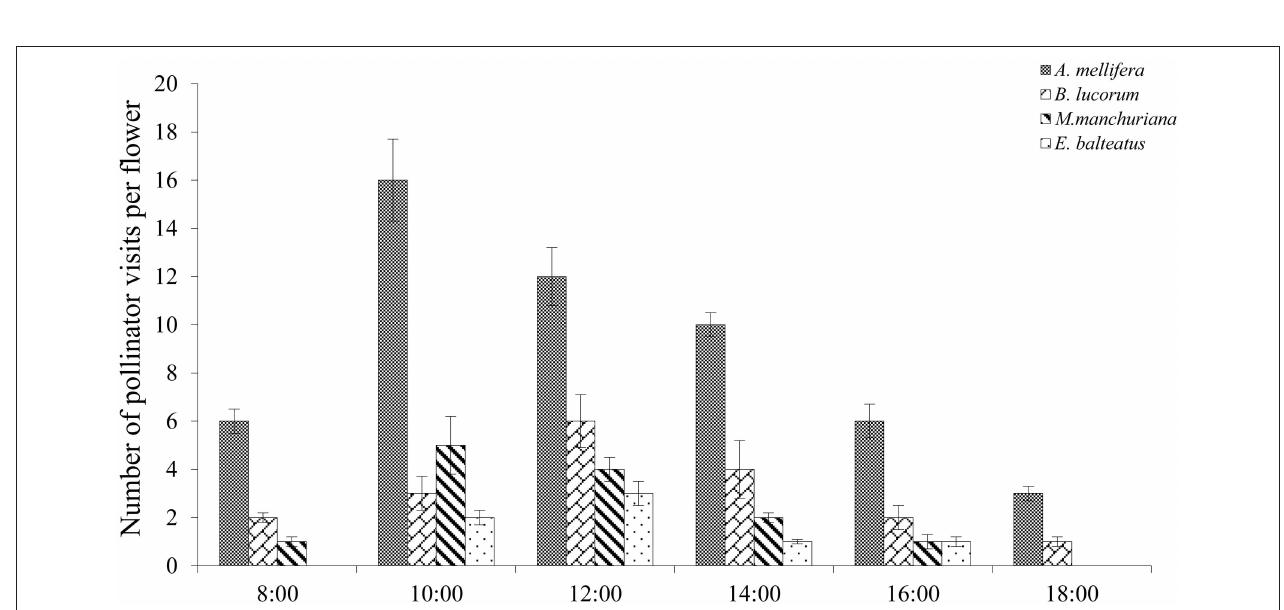
FIGURE 4 | Relationship between the proportion of seeds per flower and the pollinator visitation rate of C. microphylla .